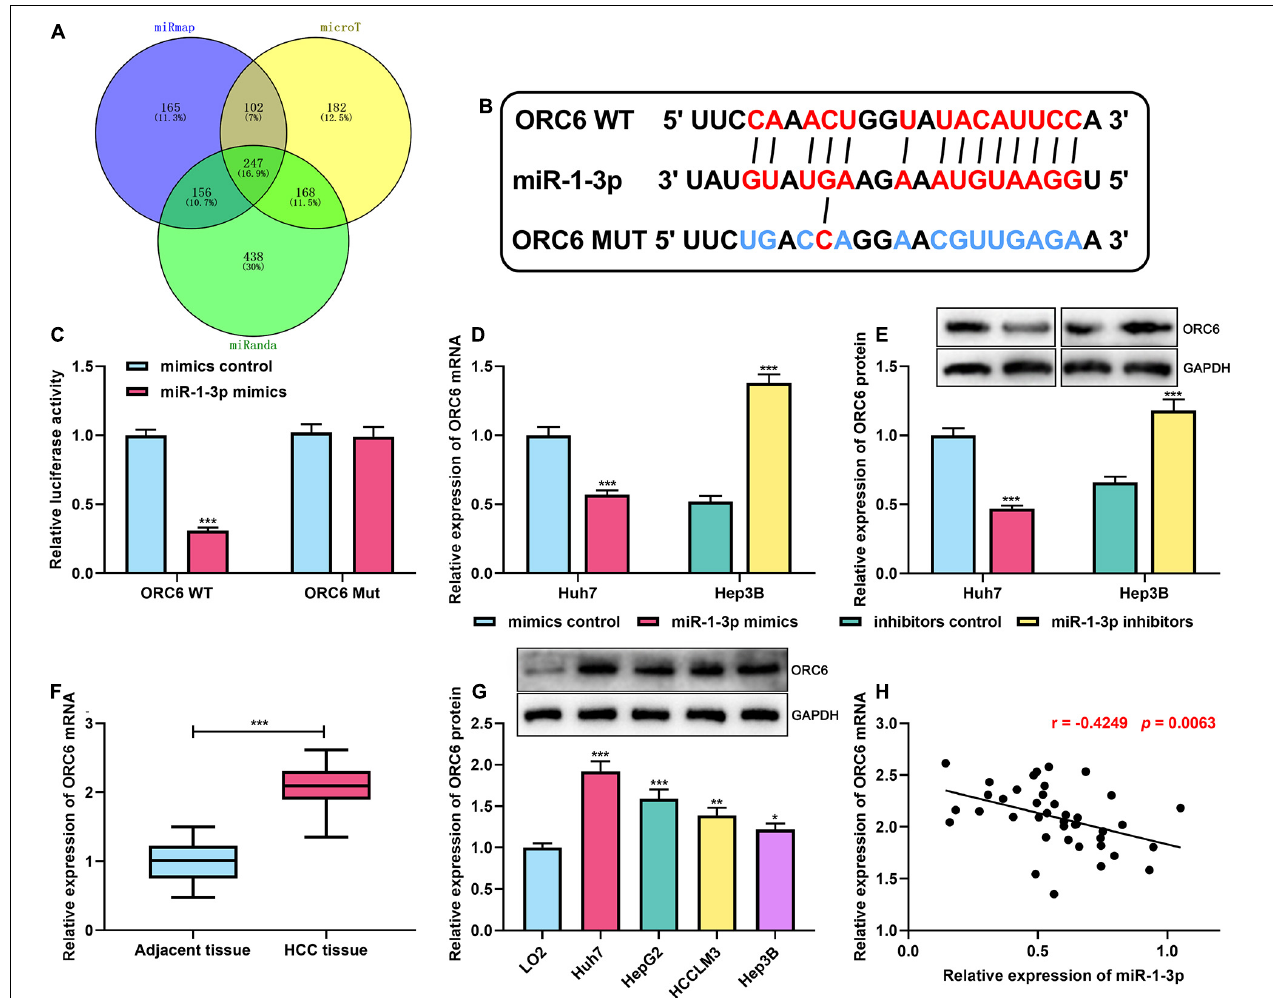
FIGURE 3 | MiR-1-3p directly targeted ORC6. (A) Venn diagram showed overlapped target genes of miR–1–3p in miRmap, microT, and miRanda databases. (B) The binding site between ORC6 mRNA 3 (cid:48) UTR and miR-1-3p was co-predicted by miRmap, microT, and miRanda databases. (C) A dual-luciferase reporter assay was performed to validate the binding site between miR-1-3p and ORC6. (D) The effect of miR-1-3p on ORC6 mRNA expression was measured by qRT-PCR. (E) The effect of miR-1-3p on ORC6 protein expression was detected by Westen blot. (F) Expression of ORC6 in HCC tissues and adjacent liver tissues was examined by qRT-PCR. (G) Expression of ORC6 in normal liver cells and HCC cell lines was examined utilizing Western blot. (H) The correlation between miR-1-3p expression and ORC6 expression in HCC tissues was analyzed. All of the experiments were performed in triplicate. *, **, and *** represent p < 0.05, p < 0.01, and p < 0.001,